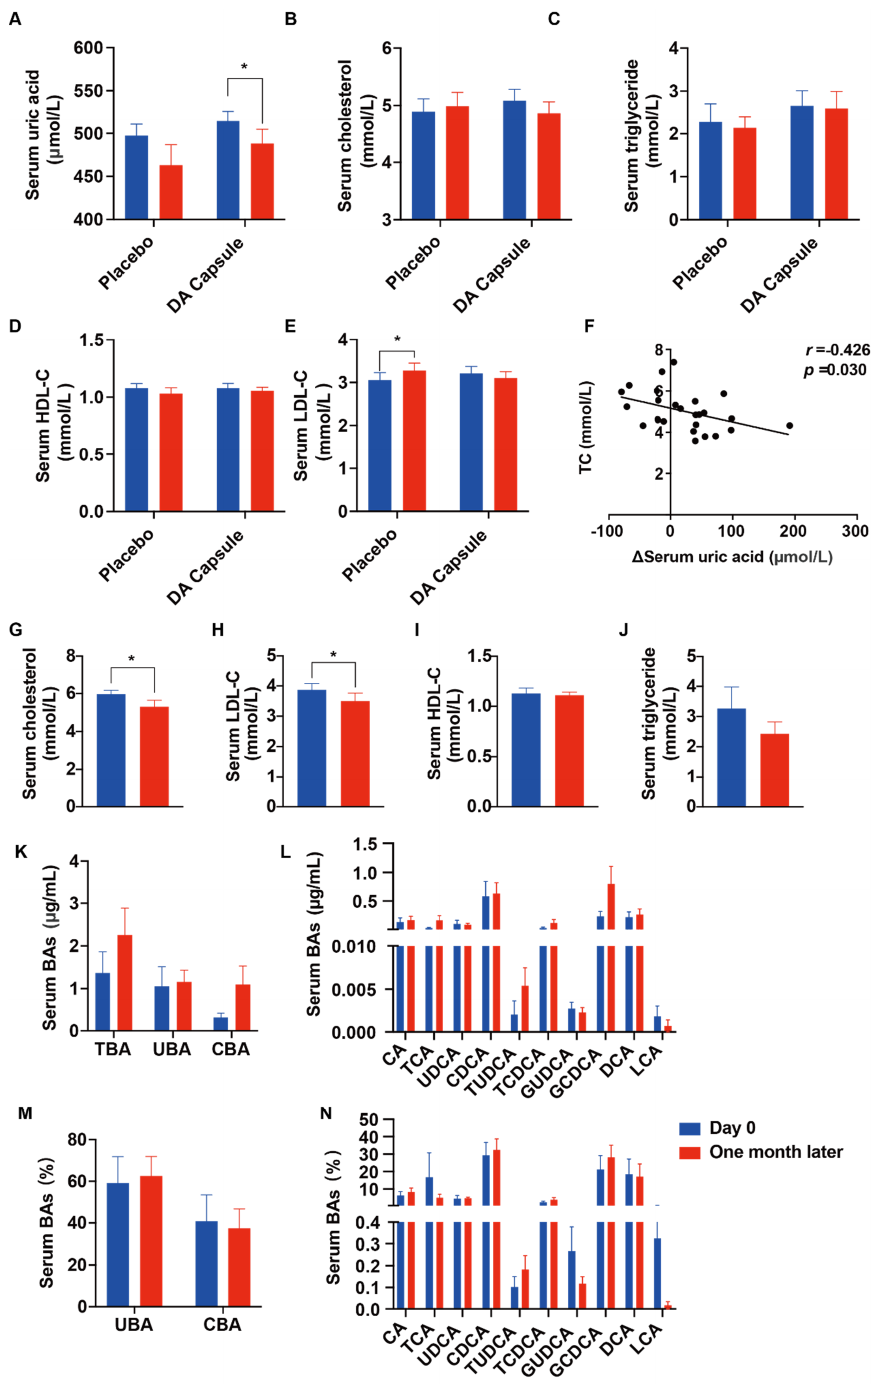
Figure 7. Effect of DA capsule on serum lipid levels and bile acid profile in hyperuricemia subjects: ( A – E ) Effects of DA capsule on serum uric acid and serum lipid levels in hyperuricemia subjects.